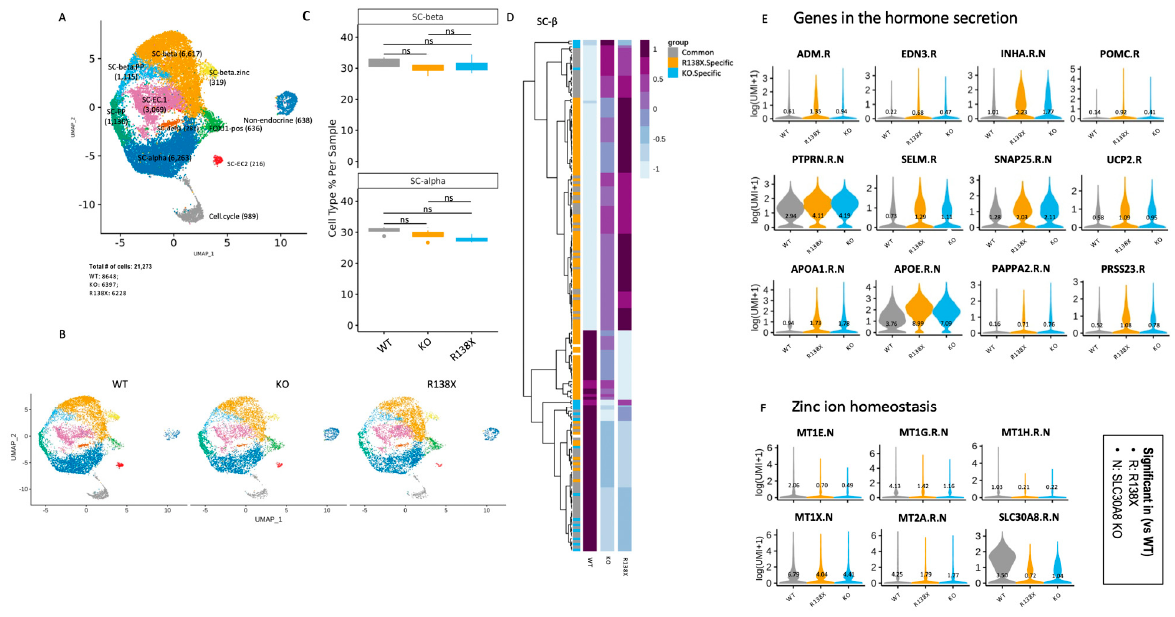
Figure 3. Single cell transcriptome analysis shows disruption of Zn 2+ homeostasis, and genes enriched in insulin secretion are upregulated in mutants. ( A ) Identified cell populations in stem cell-derived islet like clusters (samples were collected from 4 independent wells of 1 experiment in each condition). ( B ) Identified cell populations in stem cell-derived islet cells separated by genotypes (WT, KO, and R138X). ( C ) Quantification of SC-beta and SC-alpha cell populations of WT, KO, and R138X. Wilcoxon test with ns: not significant. ( D ) The upregulated and downregulated genes in WT, KO, and R138X stem cell-derived beta cells. ( E ) Genes in hormone secretion pathway upregulated in SLC30A8 mutants (KO and R138X). ( F ) Genes in zinc ion homeostasis pathway downregulated in SLC30A8 mutants (KO and R138X).